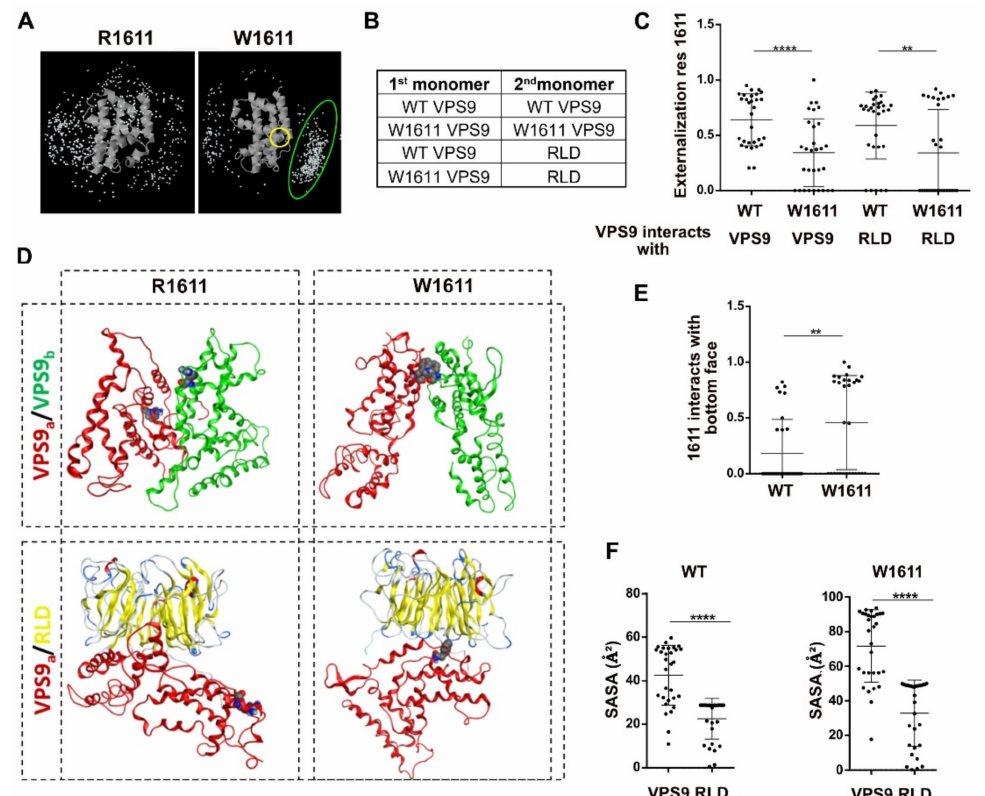
Figure 4. Interaction modes of WT and R1611W VPS9. ( A ) Interaction profiling of the space around VPS9 core. W1611 and its interaction cluster are, respectively, highlighted in yellow and green. ( B ) Scheme of submitted docking. ( C ) Externalization weighted score of residue 1611 in the dimers; each dot is a dimer pose; statistics: one-way ANOVA:( D ) Representative structures from ClusPro docking study. ( E ) Interaction of residue 1611 with the RLD bottom hydrophobic surface; each dot is a dimer pose; statistics: unpaired t -test. ( F ) SASA of residue 1611 in the four complexes from ( B ); each dot is a dimer pose; statistics: unpaired t -test. p -value < 0.01 is **, p value < 0.0001 is